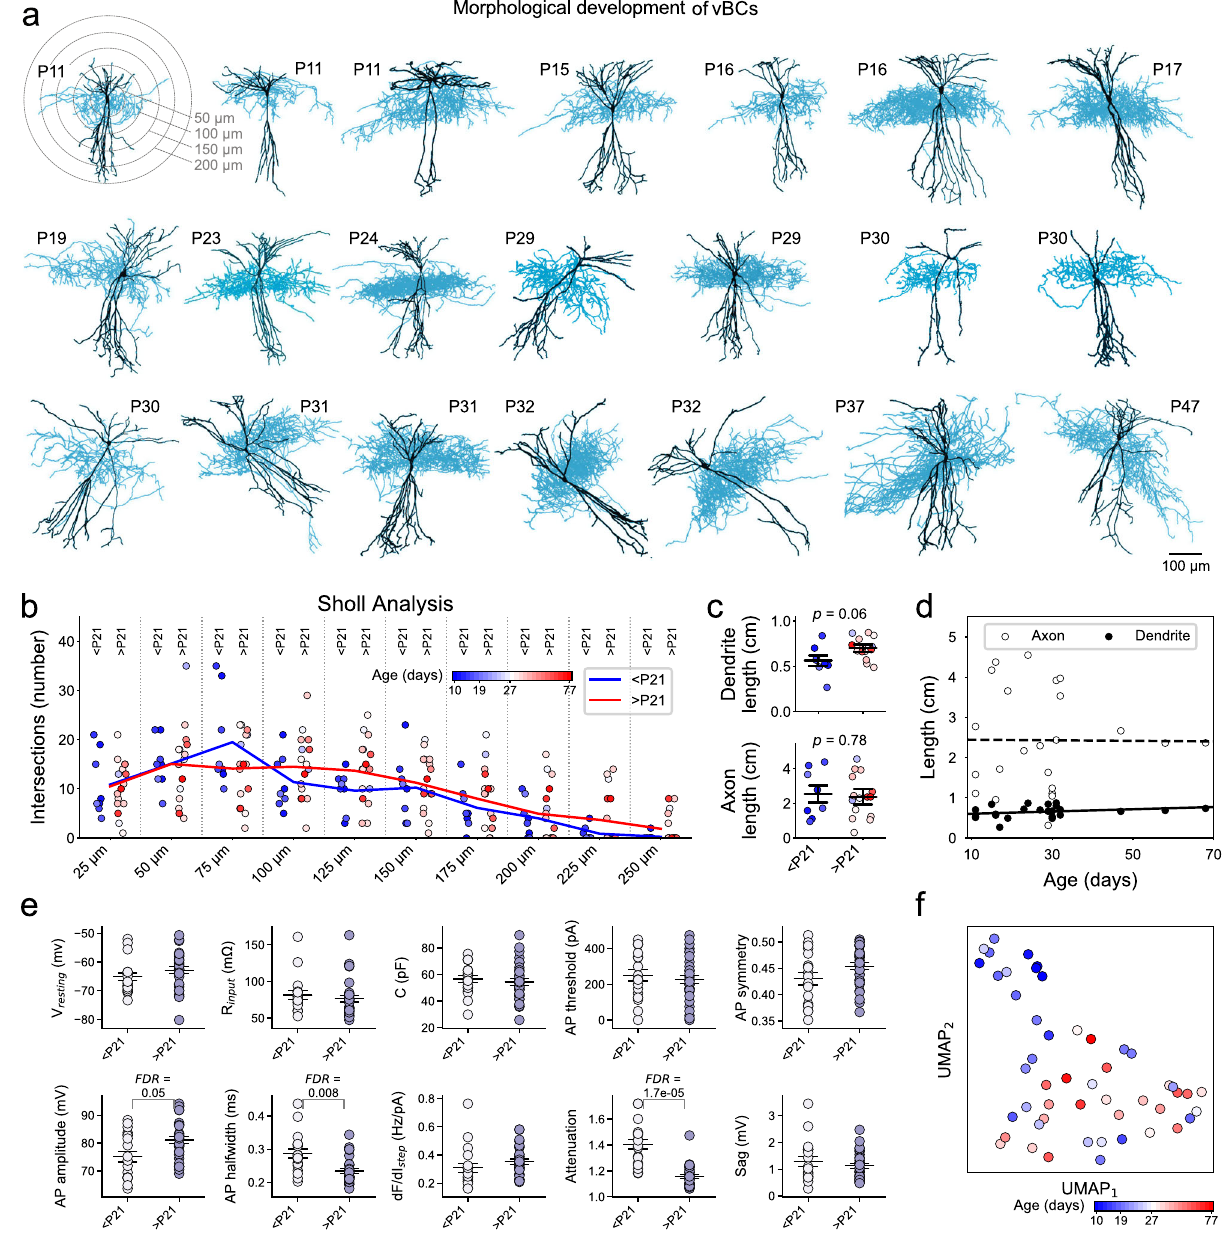
Fig. 6 Morphological and electrophysiological analysis of vBC type PV-INs during circuit maturation. a Morphological reconstructions show vBC type PV-INs at different ages. The fi rst image shows Sholl analysis for dendritic branching based on concentric 3D spheres (plot shows circles for clarity). b Plot shows the number of intersections at different distances from the soma of n = 8 < P21 and n = 16 > P21 vBC. Circles denote individual cells, which represent a randomly chosen subset (~50%) of all <P21 and >P21 vBC cells included in the whole study. None of the statistical comparisons (two-sided Welch ’ s t test) revealed a FDR smaller than 0.255. c Plots show the total dendritic (left) and axonal (right) length of <P21 and >P21 vBC-type cells. P values are shown on top and were determined using two-sided Welch ’ s t test. Data represent mean ± S.E.M. d Scatter plots and linear regression fi ts of axon and dendrite length against age. Neither value was shown to correlate with age (lowest P value and highest r 2 for fi t were 0.272 and 0.209, respectively). e Plots show electrophysiological properties of n = 19 < P21 versus n = 31 > P21 vBC type PV-INs. Attenuation (FDR = 1.7 × 10 − 5 , two-sided Welch ’ s t test), AP half-width (FDR = 0.008) and AP amplitude (FDR = 0.05) show signi fi cant changes. Data represent mean ± S.E.M. f UMAP-based dimension reduction of electrophysiological properties of vBC-type cells. All cells represent the vBC type and are colored by